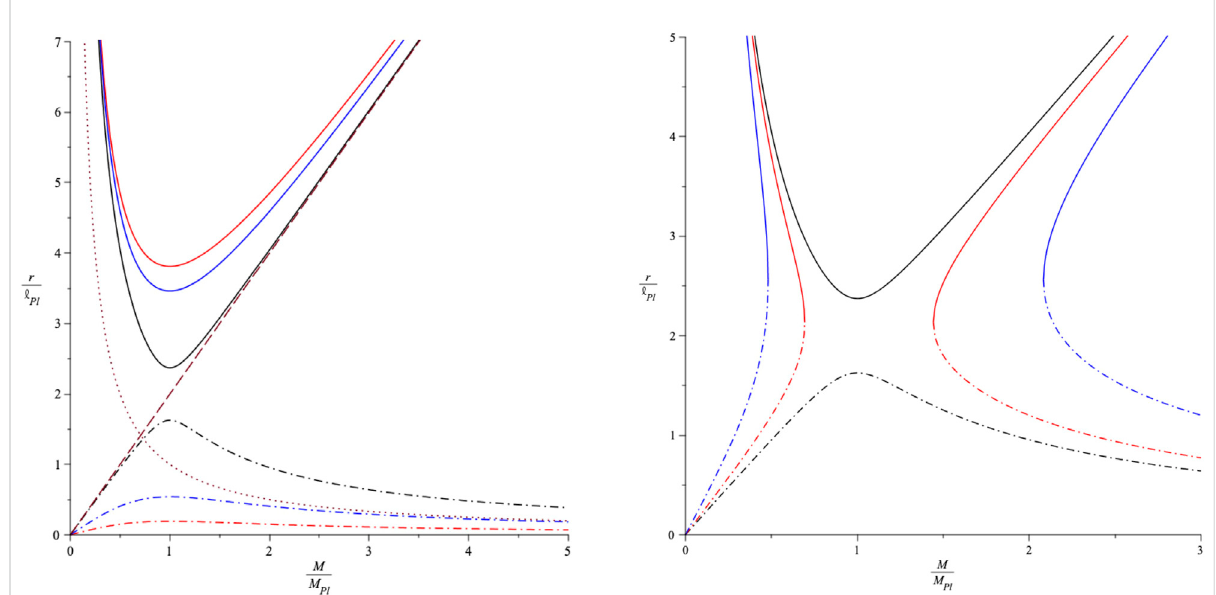
FIGURE 4 Outer (solid) and inner (dash-dot) horizon size for GUP-RN black hole with β = 2. Left: Outer (top) and inner (bottom) horizons for n = 10 (red), n =16(blue)and n =23(black).Thedashed/dottedlinesshowtheusualSchwarzschild/Comptonscales.Theinnerhorizonisnearlyasymptotictothe Comptonwavelengthatlarge M for n =16.Thereisadiscontinuitywhen n reaches23,thisbeingclosetoanextremalsolution.Right:Outer(top)and inner(bottom)horizonsfor n =23(black), n =25(blue)and n =30(black).Thehorizonsinthiscasehaveamaximumvalueof M ontheleftanda minimum value on the right. There are no black holes between these values. From Carr et al.